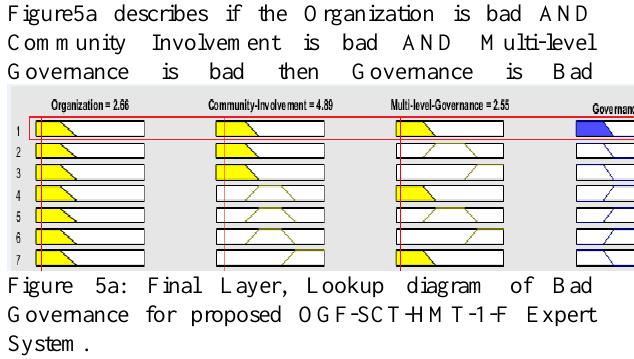
Figure 4c . Rules Surface of governance quality b ased upon: Organization and Community- Involvemen